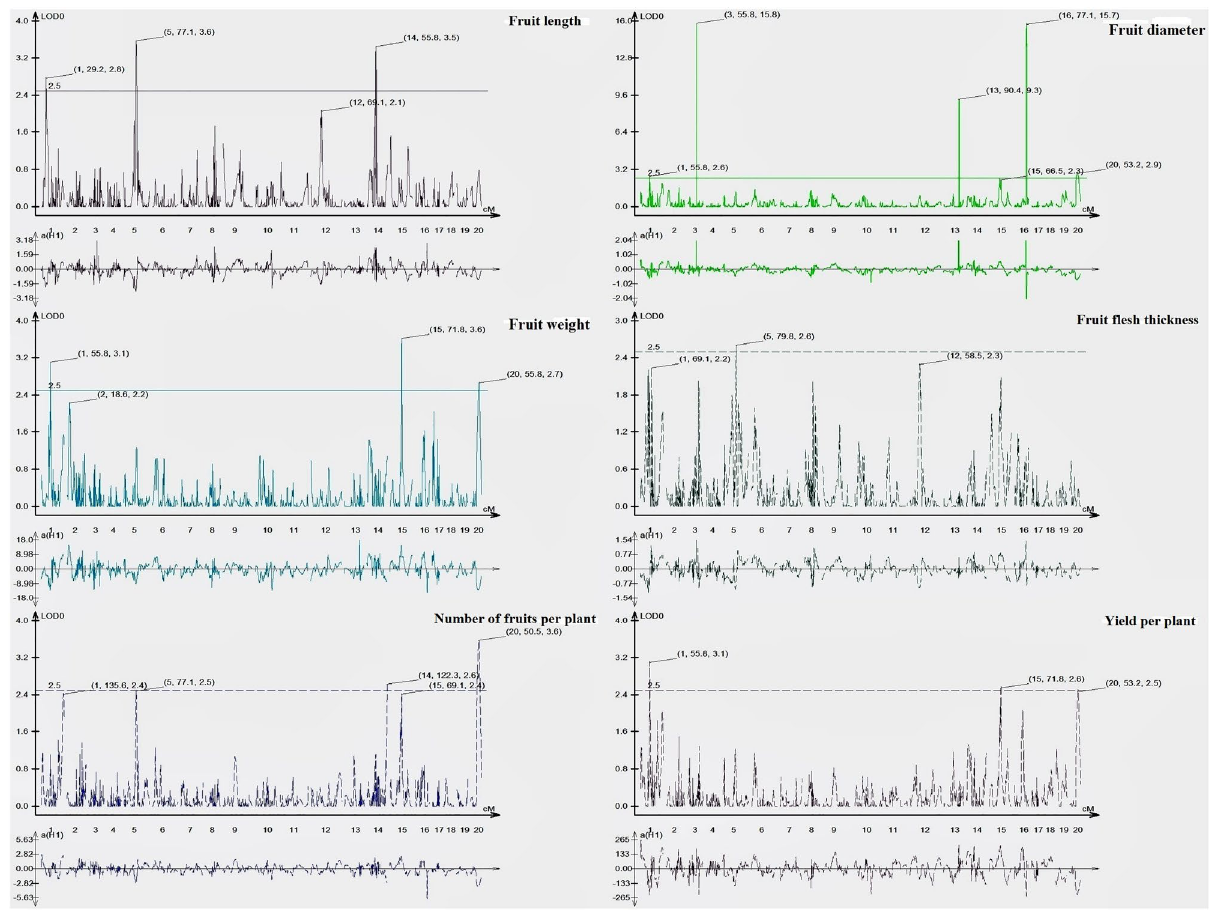
Figure 2. QTL LOD plot generated using QTL cartographer for the fruit traits of bitter gourd F 2:3 family of a cross DBGy-201 × Pusa Do Mausami representing the linkage group, cM position and LOD value on the respective